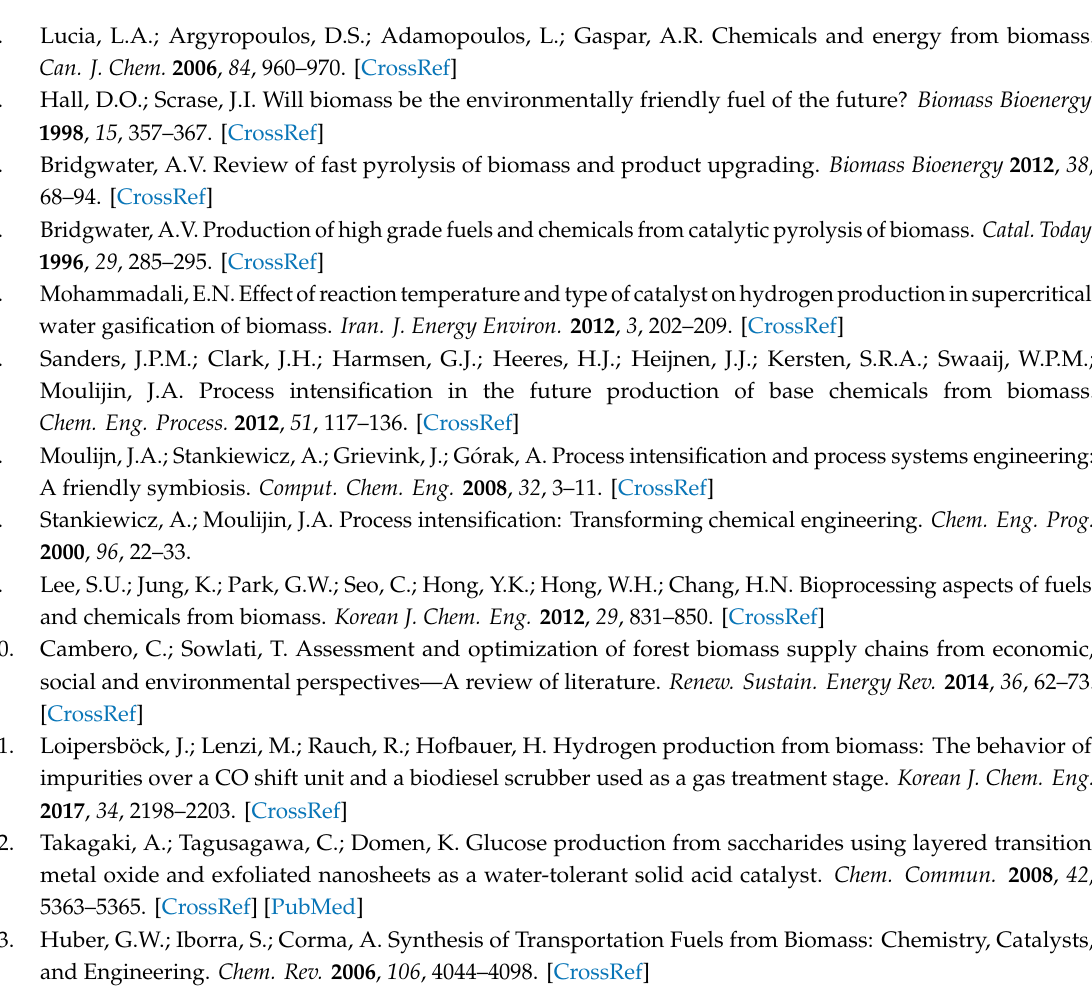
Figure S1. Hammett indicator method of prepared HTX catalyst (X = 1.5, 2, 3, and 4). (a) Bromothymol blue (H_ = 7.3) in water, (b) Phenolphthalein (H_ = 9.5) in water, (c) Bromothymol blue (H_ = 7.3) in MeOH, (d) Phenolphthalein (H_ = 9.5) in MeOH, (e) Bromothymol blue (H_ = 7.3) in DMSO, (f) Phenolphthalein (H_ = 9.5) in DMSO, (g) Bromothymol blue (H_ = 7.3) in DMF, (h) Phenolphthalein (H_ = 9.5) in